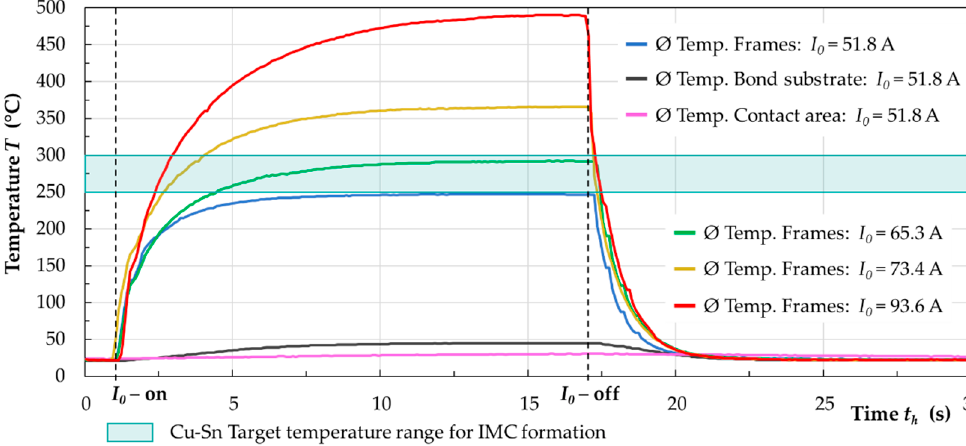
Figure 21. Temperature-time curves the bond substrate, the contact area, and the inductively heated bond frames for currents in the range of I 0 = 51.8 A to 93.6 A and a time range of t h = 0 s to 30 s. The results show that the temperatures in the bond frames increase continuously with rising current and time. After t h = 10 s, a temperature plateau is reached for all coil currents. Consequently, a current of about I 0 = 65 A with a heating time of t h = 5 s is necessary to reach the minimum target temperature of 250 °C for the formation of the intermetallic phases in the Cu-Sn binary system. After interrupting the coil current I 0 , the frames cool down to almost room temperature in Δ t ≈ 5 s. Due to the water-cooled bonding module, convection (4) and conduction (5) play a dominant role in the heat dissipation. 4.4. Inductive Bonding The bond process was performed using the inductive bonding system (Figure 15). Figure 22a shows a heterogeneous substrate stack consisting of silicon and glass after inductive Cu-Sn SLID bonding. For the process preparation, the inductive bonding module was used to place the silicon and glass chips with the Cu-Sn frames on top of each other. For this, the bracket of the module served as a mechanical alignment guidance to adjust the two substrates to each other. After positioning the bond chips, a tool force of F = 210 N was applied, corresponding to an effective bond pressure of p = 3 MPa in the frames. A coil current of I 0 = 78.6 A with a frequency of f 0 = 1.898 MHz was applied to initiate the diffusion process. The current and frequency deviated slightly, compared to the values from the inductive heating experiments (Section 4.3), since the impedance of the entire system changed due to additional components (e.g., adapter and pressure plates). A heating time of t h = 120 s was used for the diffusion process. The tool pressure was kept for ten more seconds after the coil current was switched off to ensure a complete phase transformation. After a bonding time of t b = 130 s, the pressure plate was retracted ( p = 0 MPa) and the bonded substrate stack could be extracted. By applying a low pressure within a bonded frame, it could be demonstrated that the resulting interferogram with light and dark lines (Newton’s rings) could not propagate outward. This indicated a sealed bond connection. The formed IMCs are shown in Figure 22b. A complete formation to the thermodynamically stable ε -phase Cu 3 Sn is observed at the outer corner of a bonded frame. At the inner frame corner, the ε -phase is enclosed by an additionally formed phase. Ramm et al. stated that significantly above 350 °C, a further reaction within the alloy may lead to the formation of Cu 4 Sn [4]. This correlates with the observations in Figure 20, where the temperature input was higher in the inner frame corners due to the proximity effect. The interface thickness after bonding was in the range of 6 µm to 6.5 µm, which means a compression of about 0.5 µm to 1 µm.